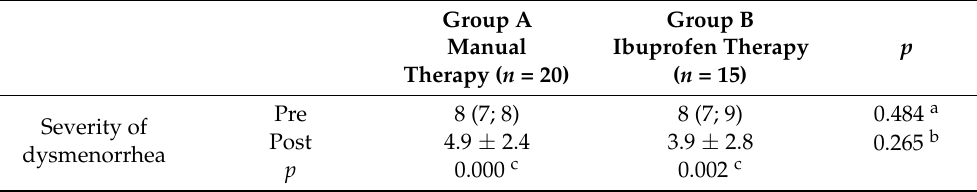
Table 7. Severity of dysmenorrhea pre and post manual or ibuprofen